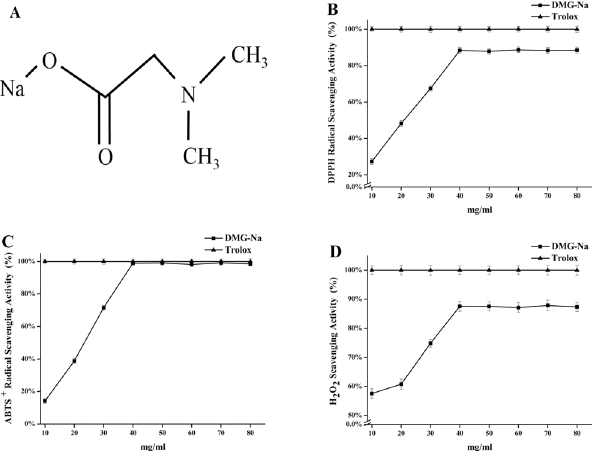
Trolox group is set to 100%. Values of DPPH and ABTS + radical scavenging ability, and H 2 O 2 scavenging ability are expressed as the mean ± SEM of three independent experiments. 1,1-diphenyl-2-pierylhydrazy (DPPH); 2,2'-Azinobis-(3-ethylbenzthiazoline-6- sulphonate) (ABTS +